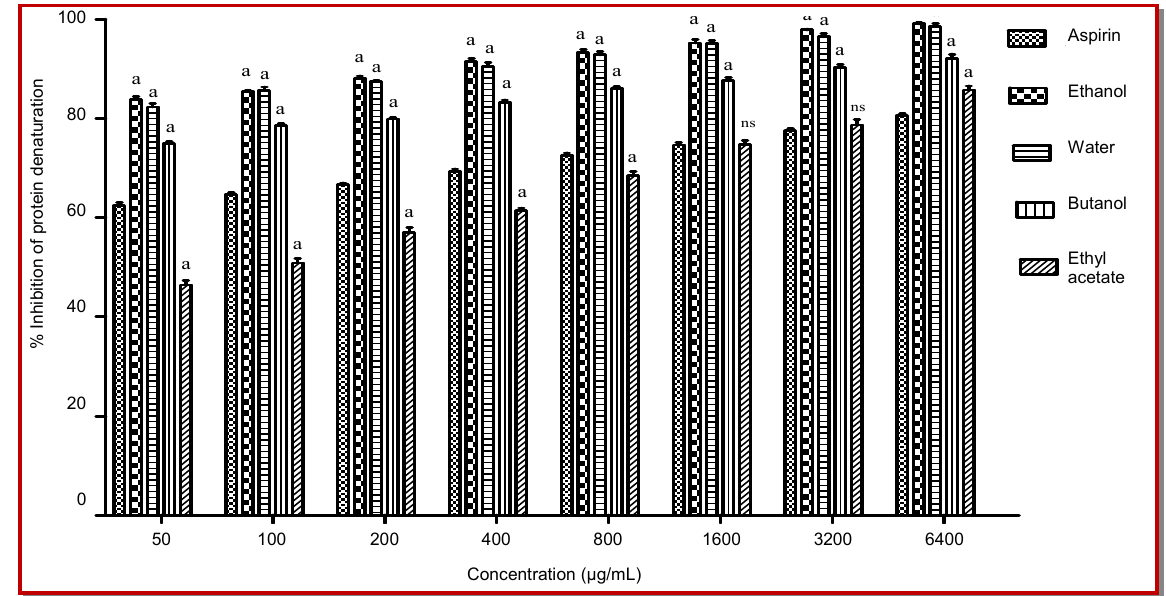
Figure 2: Effect of EG on inhibition of protein (BSA) denaturation. Results are expressed as mean ± SEM (n=3), using two way ANOVA followed by Bonferroni posttest. a p<0.001, ns non-significant when compared to standard